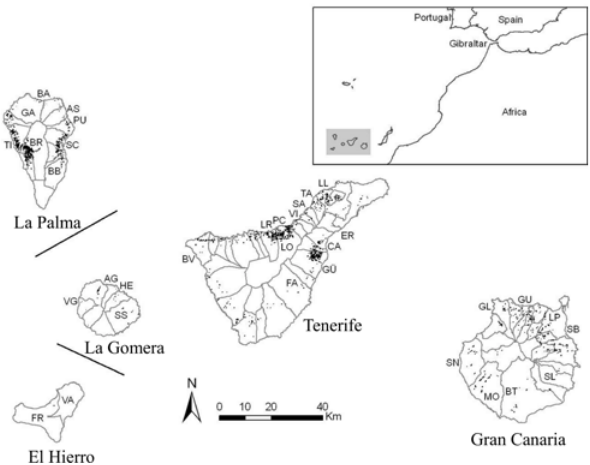
Figure 1. Map showing locations of the Canary Islands (upper square) and enlarged views of La Palma, Tenerife, Gran Canaria, La Gomera and El Hierro (from the shaded square). Avocado plantations in the Canary Islands are highlighted in black. The map indicates the townships and the abbreviated names of places where samples were col- lected (see Table 2 for